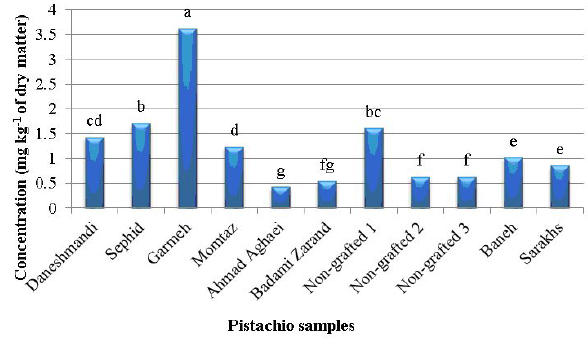
Fig. 5. The nickel concentration of eleven Iranian pistachio sam- ples. (Each column with different letters is significantly different (P <